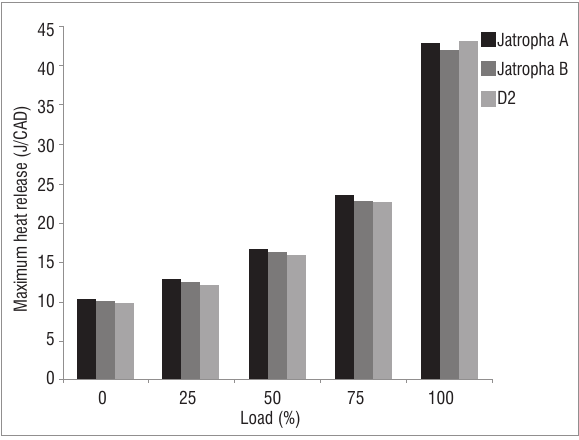
Figure 9: Maximum rate of heat release at different engine